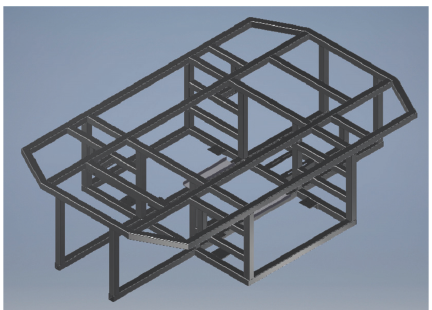
Figure 7: Isometric view of the AGV chassis.